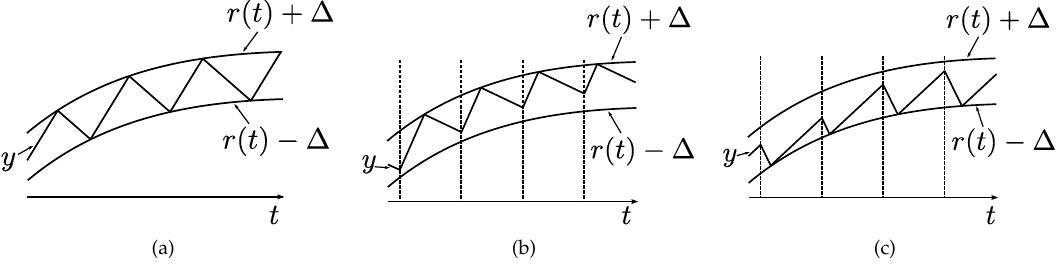
Figure 2. Evolution of the controlled output and its reference in sliding-mode for three types of control implementing (14). ( a ) Hysteresis control. ( b ) Peak control at constant switching frequency. ( c ) Valley control at constant switching